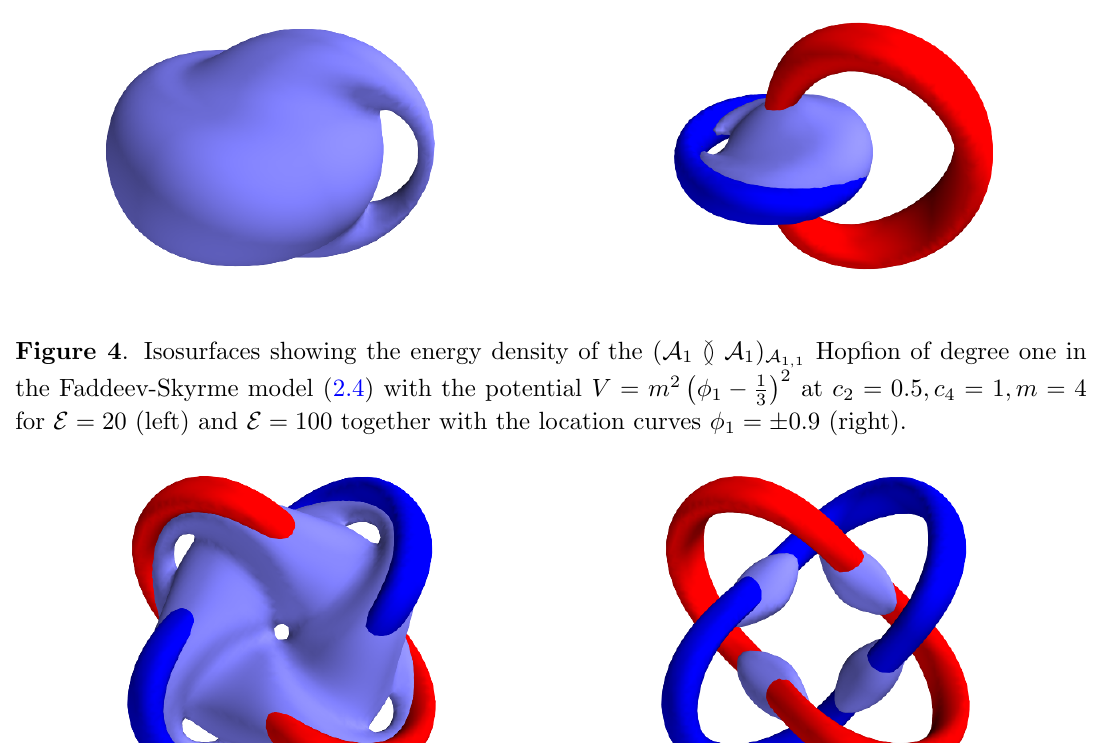
Hop(cid:12)on in the Faddeev- 2 ; 1